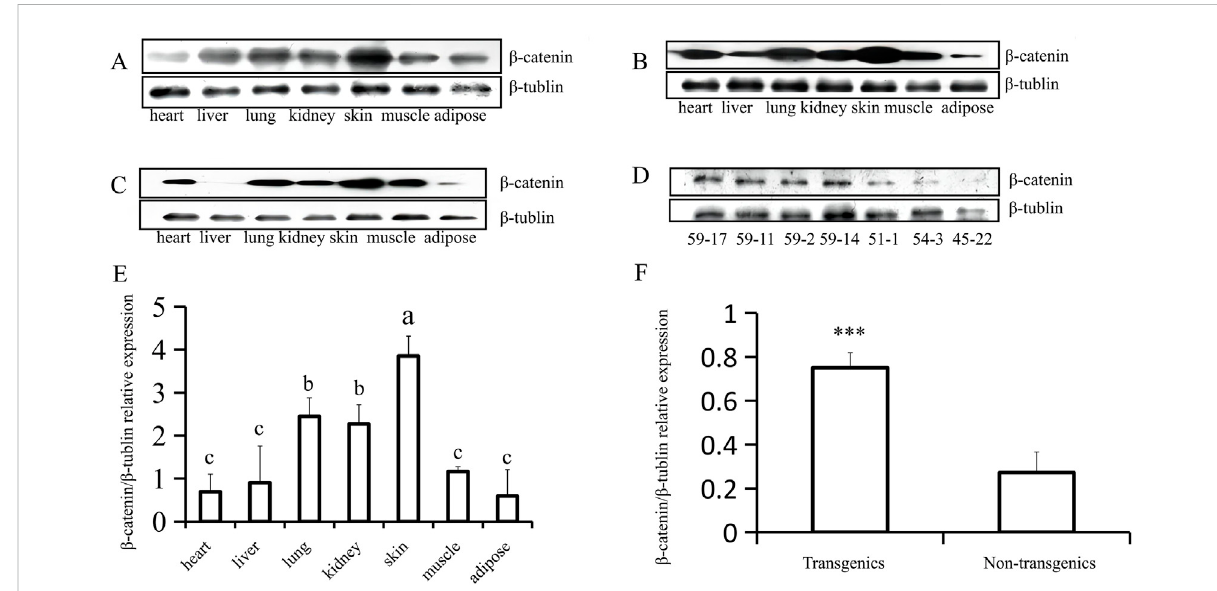
FIGURE 4 Western-blotanalysis of β -catenin protein expression inheart, liver, lung,kidney, skin,muscle and adipose (F1). (A) (B) and (C) The analysis of β - catenin protein expression in different tissues of three transgenic mice (59 – 17, 59 – 2, and 59 – 11). (D) The expression of β -catenin protein in transgenic (59 – 17,59 – 11,and59 – 2)andnon-transgenicmice(51 – 1,54 – 3,and45 – 22). (E) Thestatisticsof β -cateninproteinexpressionindifferent tissuesoftransgenicmouselines,thebarswithcommonlowercaselettershadnosigni fi cantdifferenceatthe5%level. (F) Comparativeanalysis of β -catenin protein expression between transgenic and non-transgenic mice. ***, p <